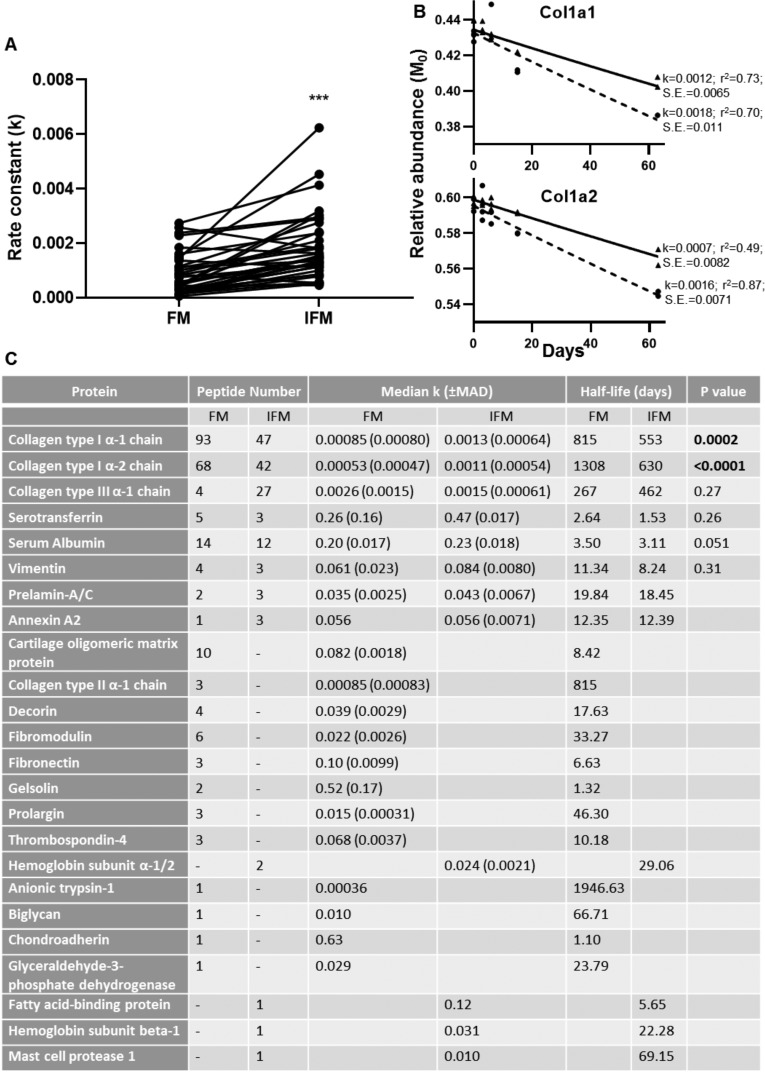
Peptide turnover rate constants and corresponding protein half-lives in tendon phases.(A) Rate constants (k) for collagen type I peptides identified in both tendon phases were significantly greater in the IFM compared to the FM (n = 39). (B) Median peptide decay curves for Col1a1 and Col1a2 in the FM (▲; solid line) and IFM (●; dashed line), showing goodness of fit (r2) and standard error (S.E.). (C) Turnover rate constants (k) and corresponding half-lives for proteins identified in each phase. *** indicates p<0.0001. Source data, generated by ProTurn are available in Figure 7—source data 1 for the FM and Figure 7—source data 2 for the IFM.Figure 7—source data 1.ProTurn output for FM.hl tab contains protein half-life information organized by peptide sequence and hl-data tab contains isotopomer relative abundance at each time point.Figure 7—source data 2.ProTurn output for IFM.hl tab contains protein half-life information organized by peptide sequence and hl-data tab contains isotopomer relative abundance at each time point.